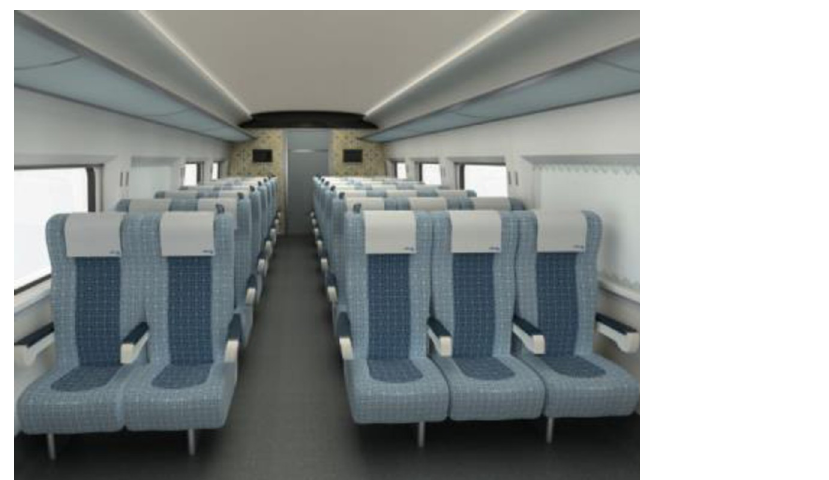
Fig 1. High-speed train (CRH380) interior environment and